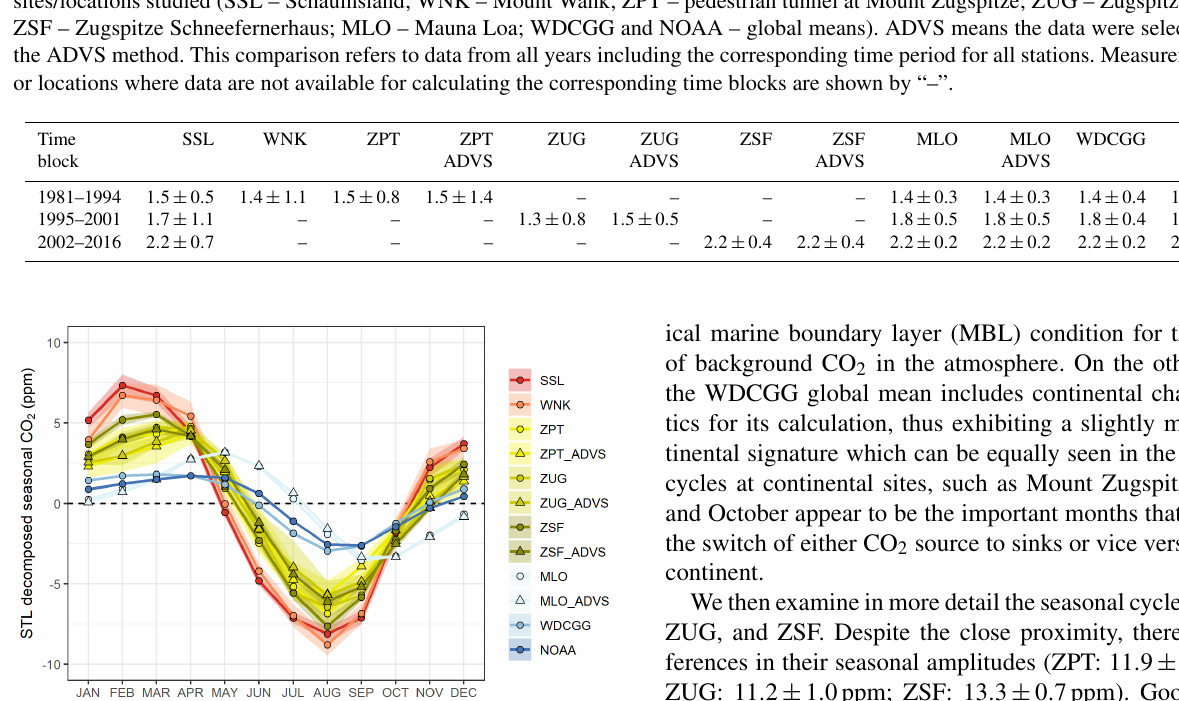
Figure 6. Mean CO 2 seasonal cycles from the STL seasonal com- ponent at each measurement site or location. Uncertainties at the 95% confidence interval are shown by the shaded areas with corre- sponding